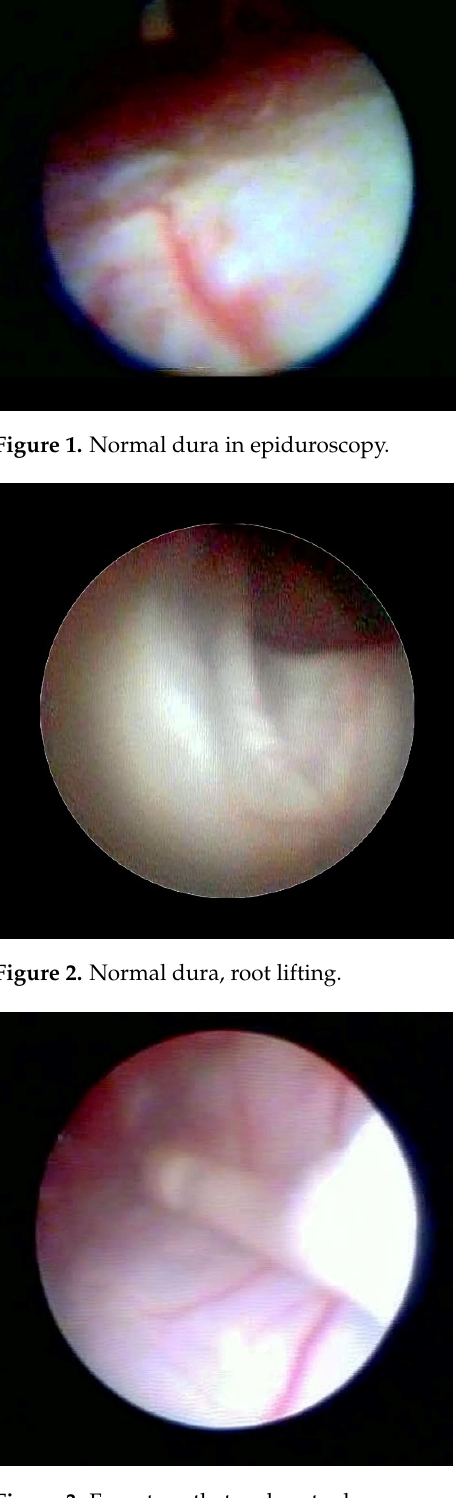
Figure 3. Fogarty catheter close to dura.